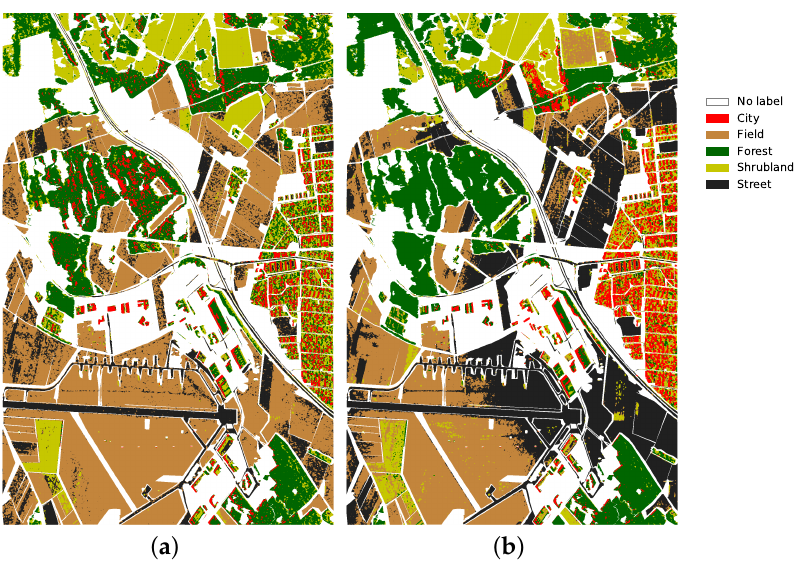
Figure 8. Classification results for supervised Wishart classifier. ( a ) PolSAR CM Wishart, BA = 72.5%; ( b ) TomoSAR CM Wishart, BA = 71.5%.